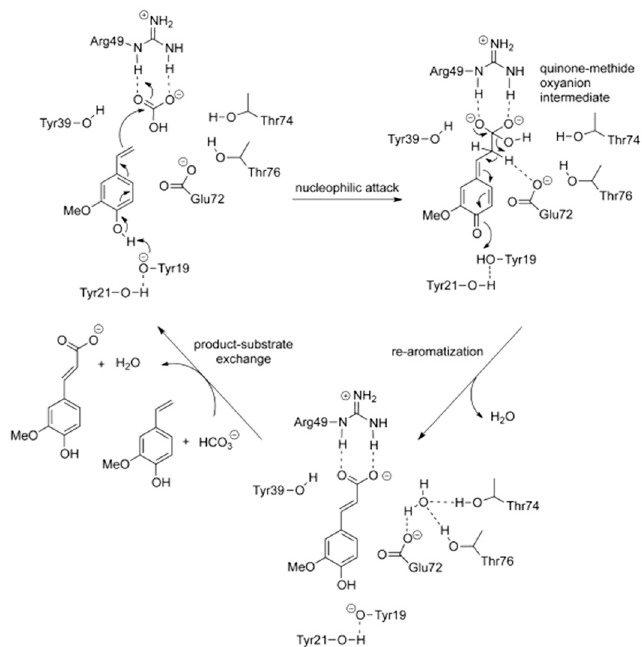
Figure 23. Proposed reaction mechanism for carboxylation of para -hydroxystyrene from PAD. Reproduced with permission from [87]. Copyright 2015, John Wiley and Sons.